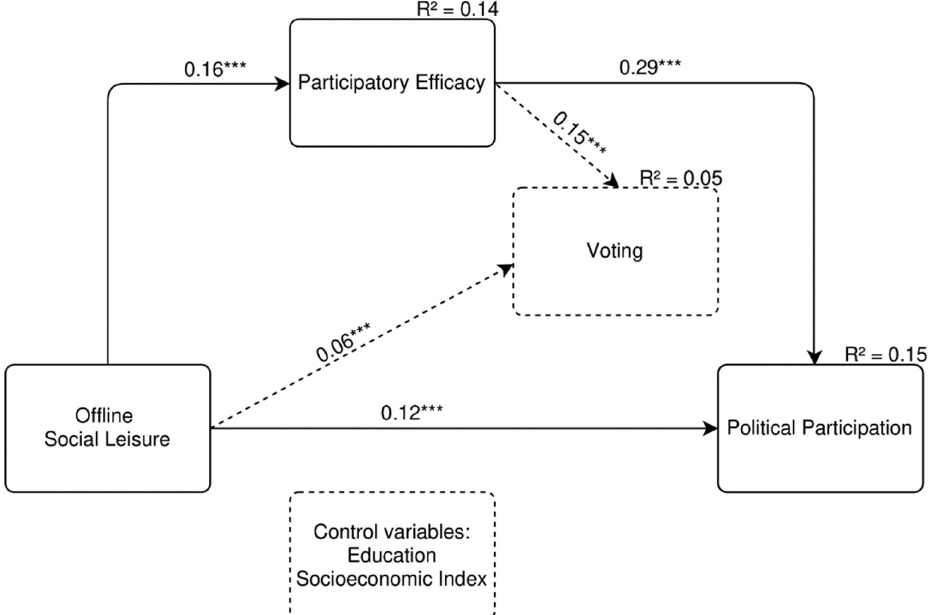
Figure A2. Pathways’ effect sizes for the conceptual model of the relationship between offline social leisure and political participation. The political participation variable does not contain voting. The full lines denote main analysis pathways, whereas dotted lines represent exploratory analysis pathways. *** p < 0.001.